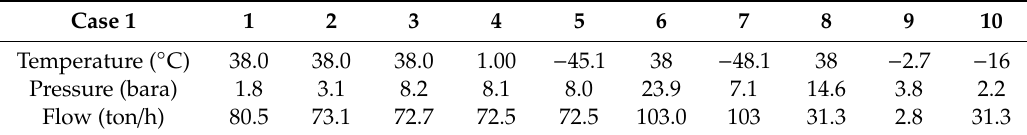
Table A1. Mass balance for the Case 1 verification model, numbering as Figure 1a.